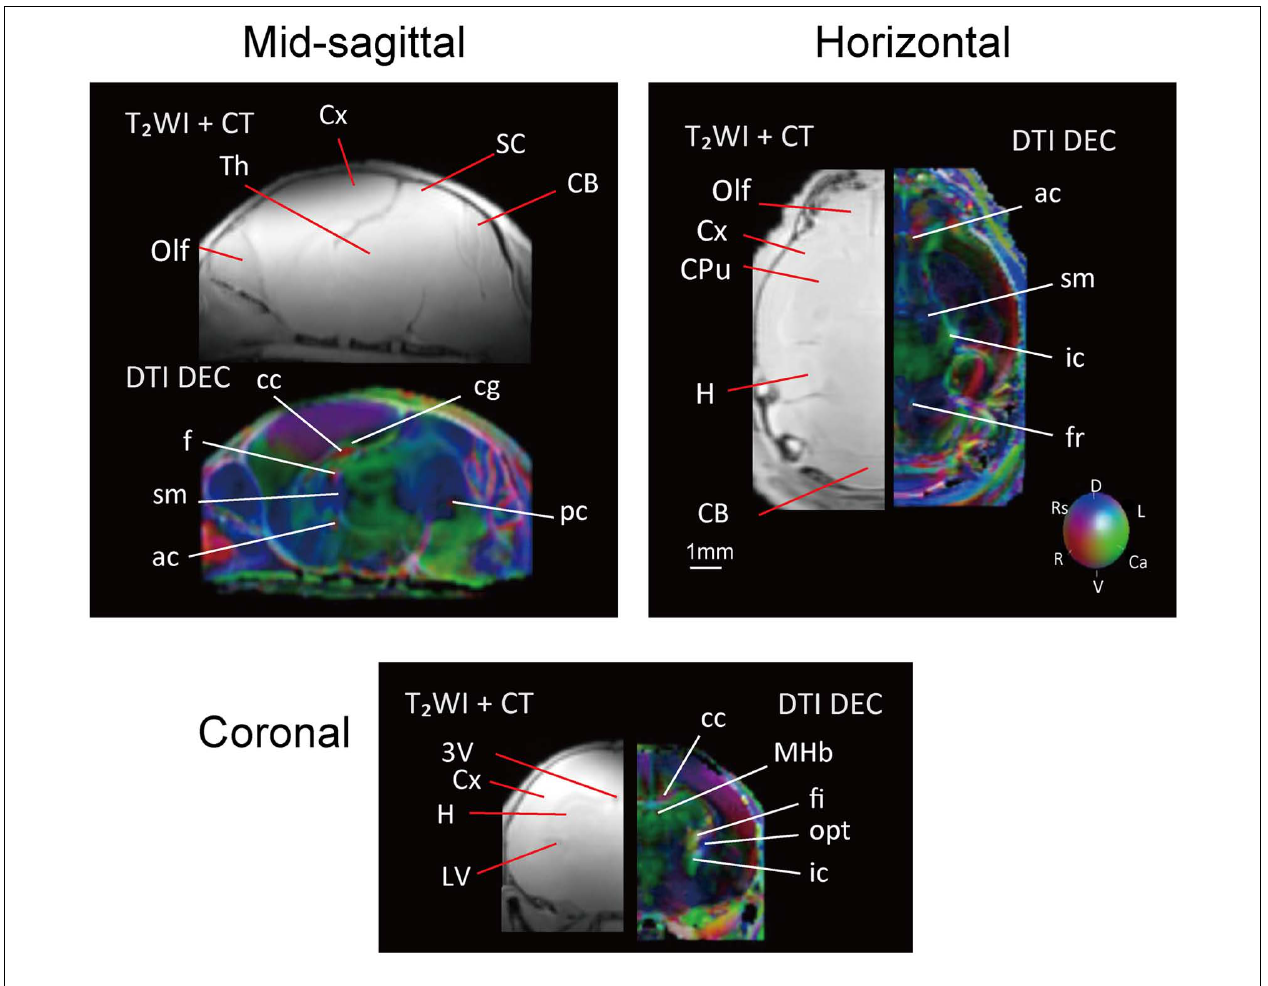
FIGURE 4 |T 2 WI and DTI of the neonatal brain in three different planes; the sagittal (upper left), horizontal (upper right), and coronal planes (center). Orientation is coded using the same color scheme as in the adult brain: red is medial–lateral, green is rostral–caudal, and blue is dorsal–ventral. Scale bar = 1 mm.